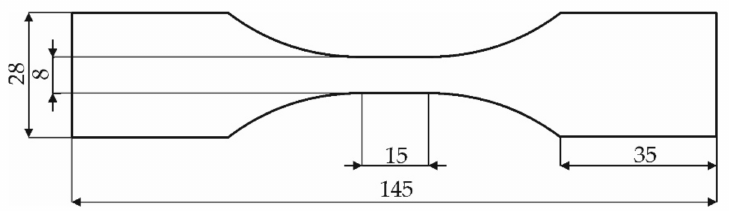
Figure 1. Specimen geometry manufactured by laser cutting, with dimensions in mm. Table 1. Chemical composition of AISI 304 sheet metal used in this work. Elem.